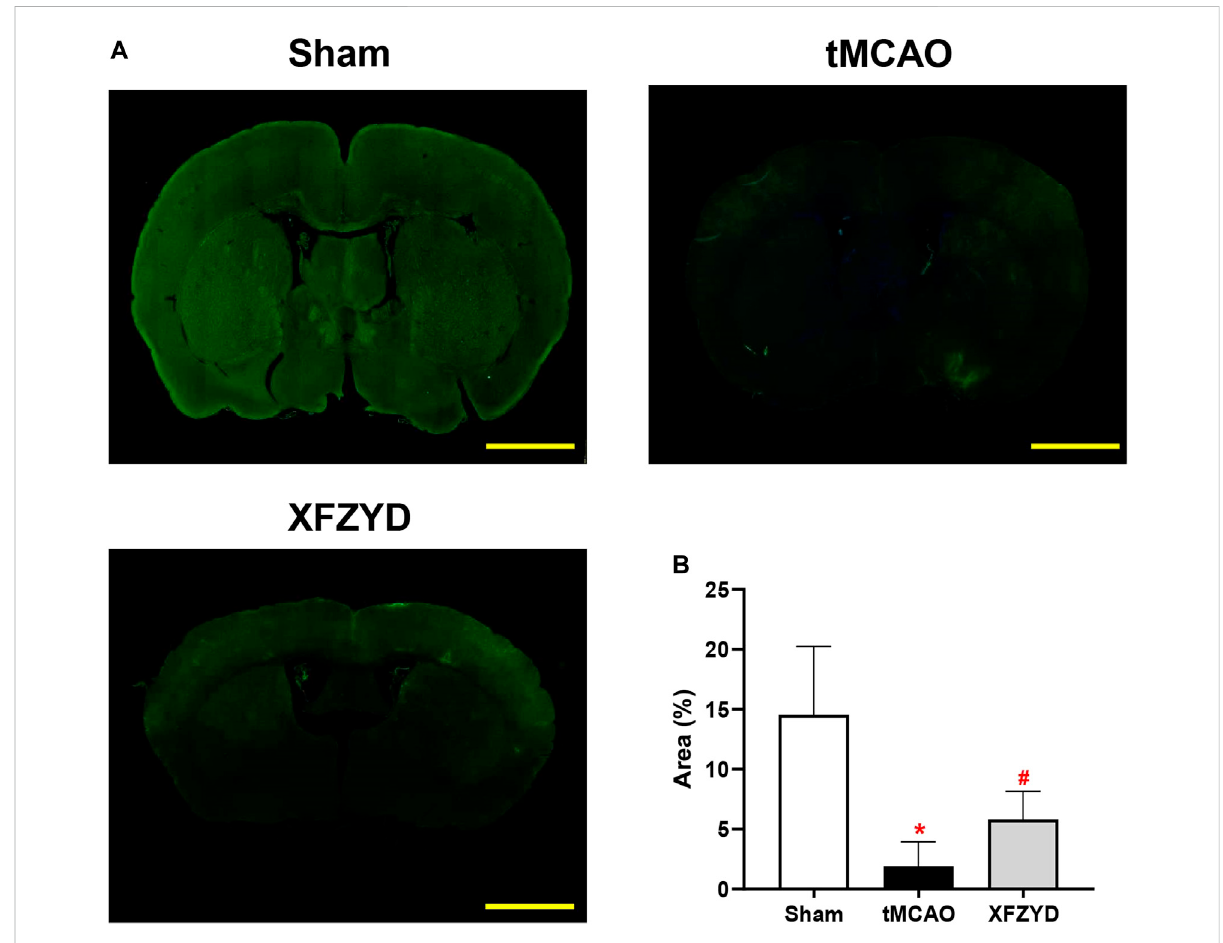
FIGURE 3 The function of the glymphatic pathway was impaired after tMCAO but rescued by pretreatment with XFZYD. (A) Representative images of coronal brain sections showing FITC-D3 distribution within the brain at 30 min (Scale bar, 1 mm). (B) Quantitative analysis of the fl uorescence intensityandpenetrationareaofdataA(n=4micepergroup,* p < 0.05vs.theshamgroup, # p < 0.05vs.thetMCAOgroup).CSF,Cerebrospinal fl uid; FITC-D3, fl uorescein isothiocyanate-conjugated